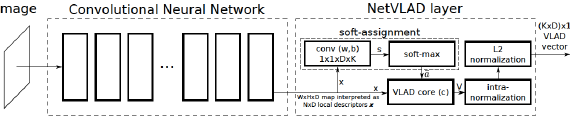
Figure 2. Workflow of the Wi-Fi fingerprinting positioning system.